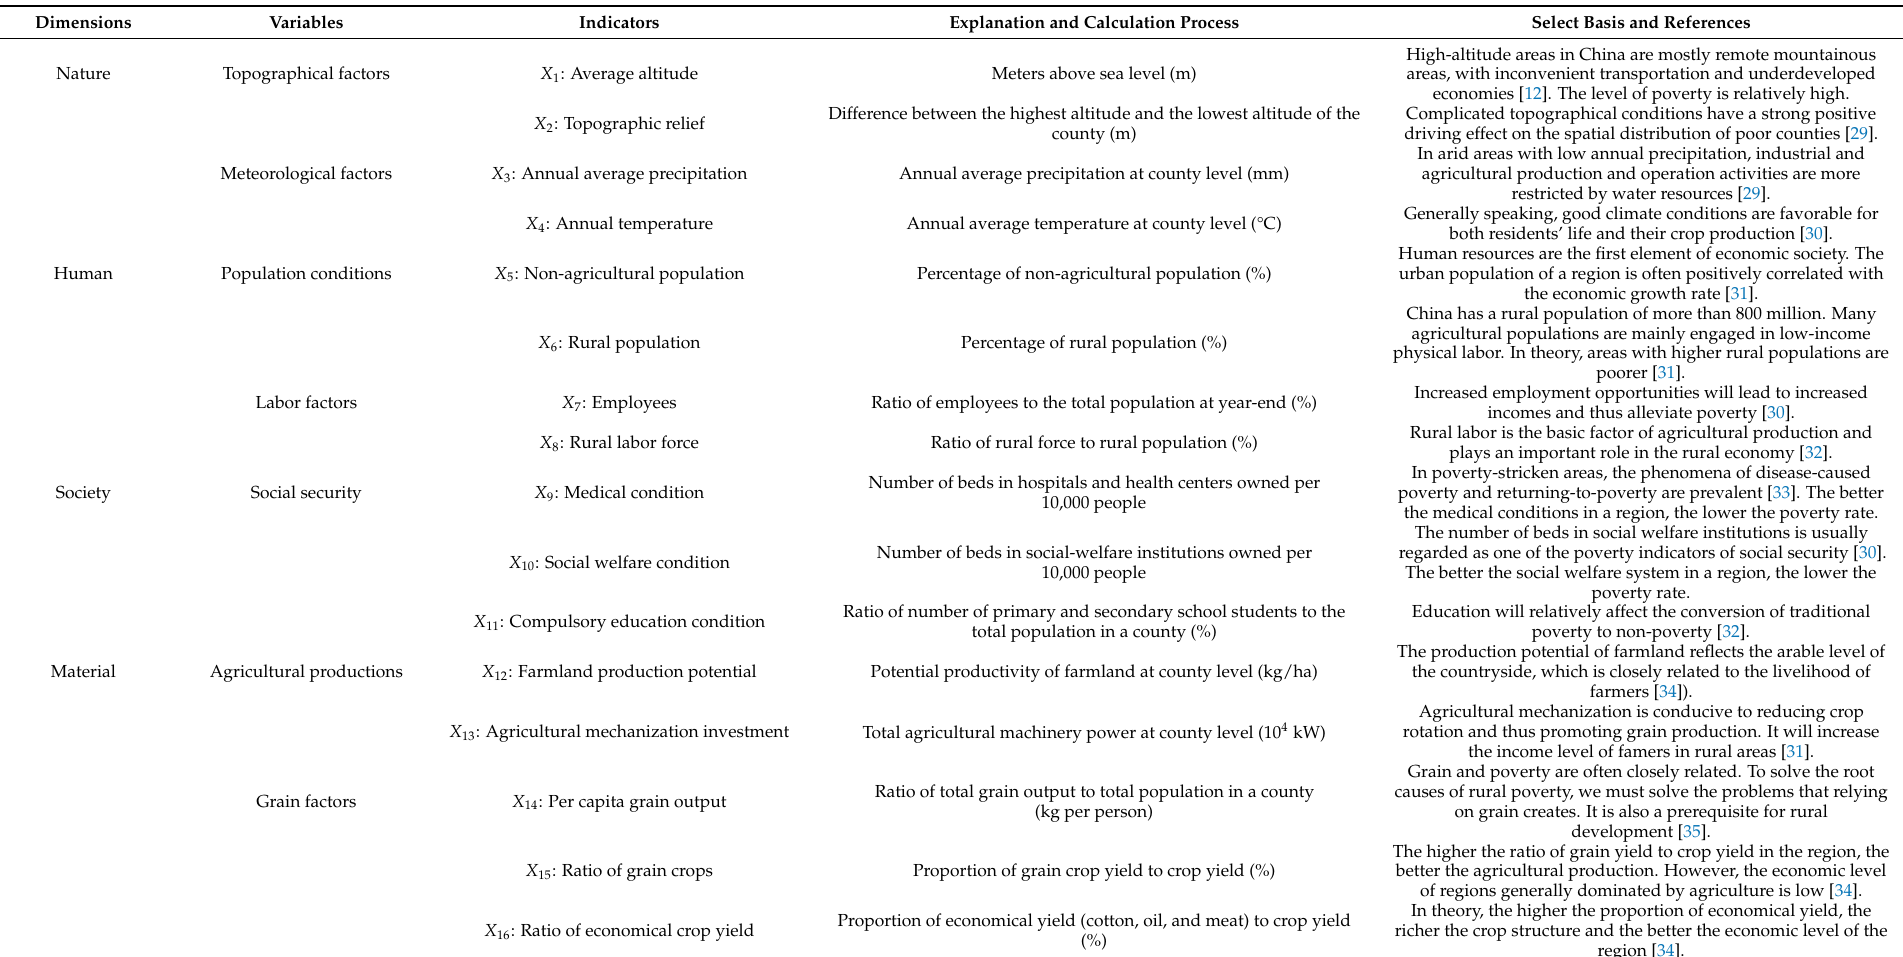
Table 2. The taxonomy and description of selected indicators at the county